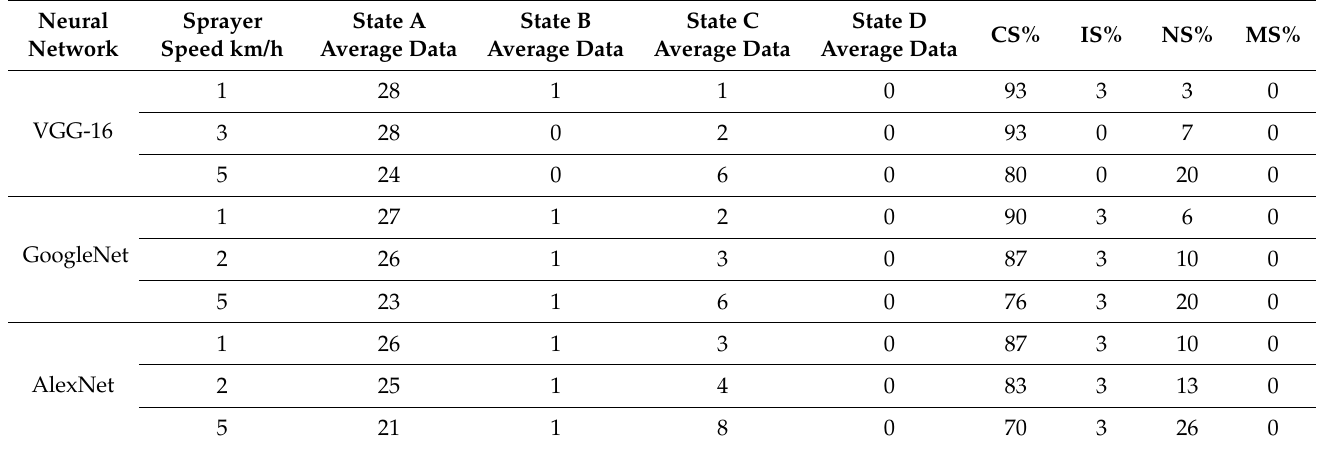
Table 4. Performance Evaluation results of spraying system in lab